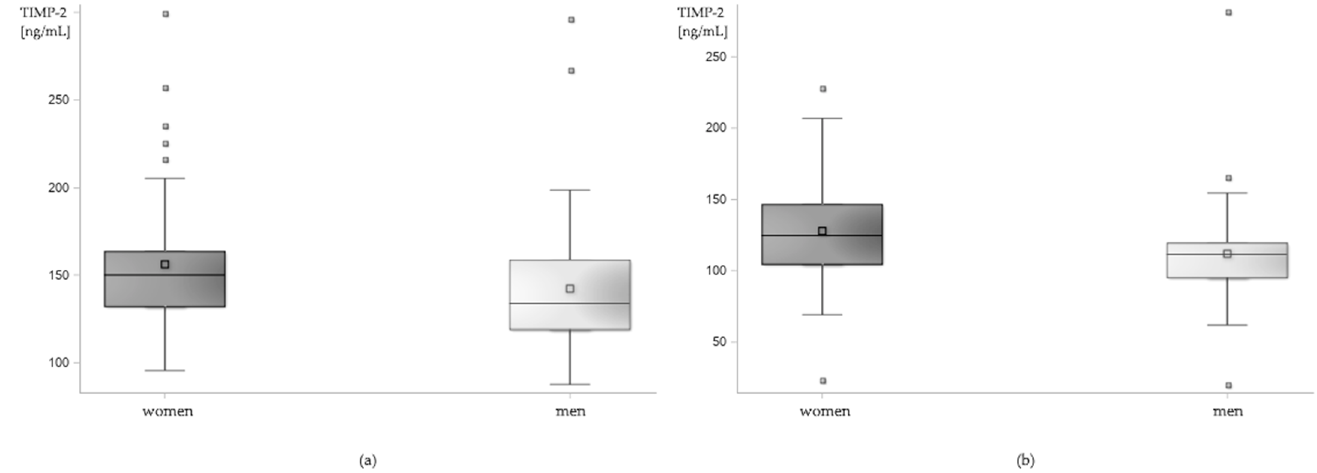
Figure 3. Sex-related differences in serum level of TIMP-2 in ( a ) patients with epilepsy and ( b ) control group. Box plot.